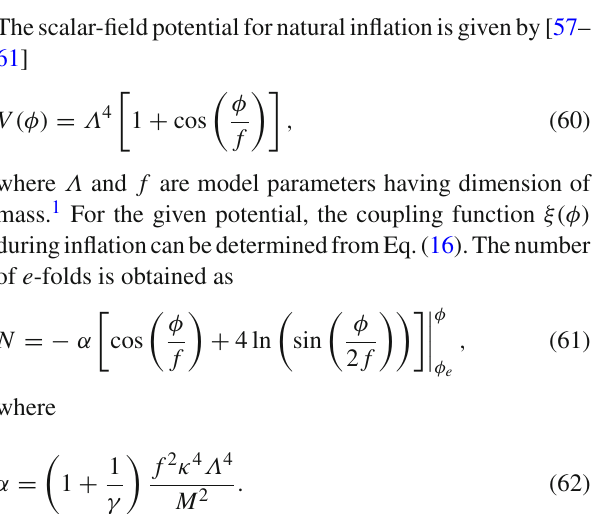
N = 60. After putting Eq. (56) into Eq. (59) and setting